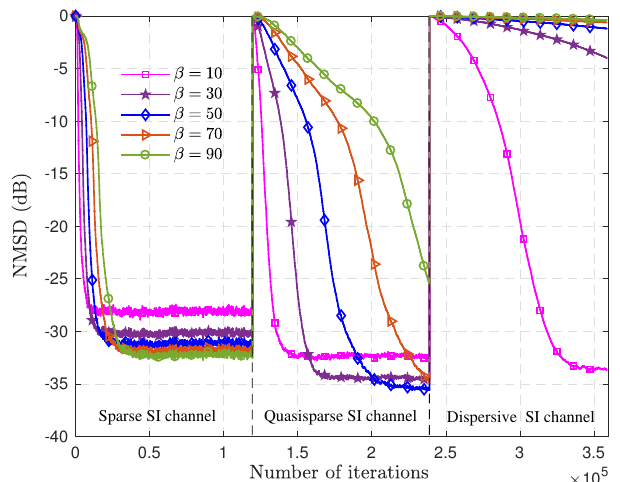
Figure 2. Normalized mean squared deviation (NMSD) curves of Arc-improved proportionate NSAF (IPNSAF) with different β under different self-interference (SI) channel